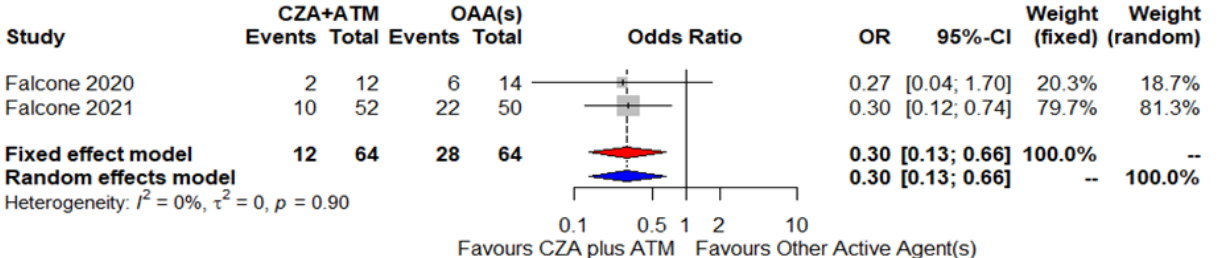
Figure 3. Forest plot of the 30-day mortality odds ratio between CZA plus ATM and other regimens against infections by MBL-producing strains. ATM, aztreonam; CZA, ceftazidime/avibactam; OAA, other active agent.